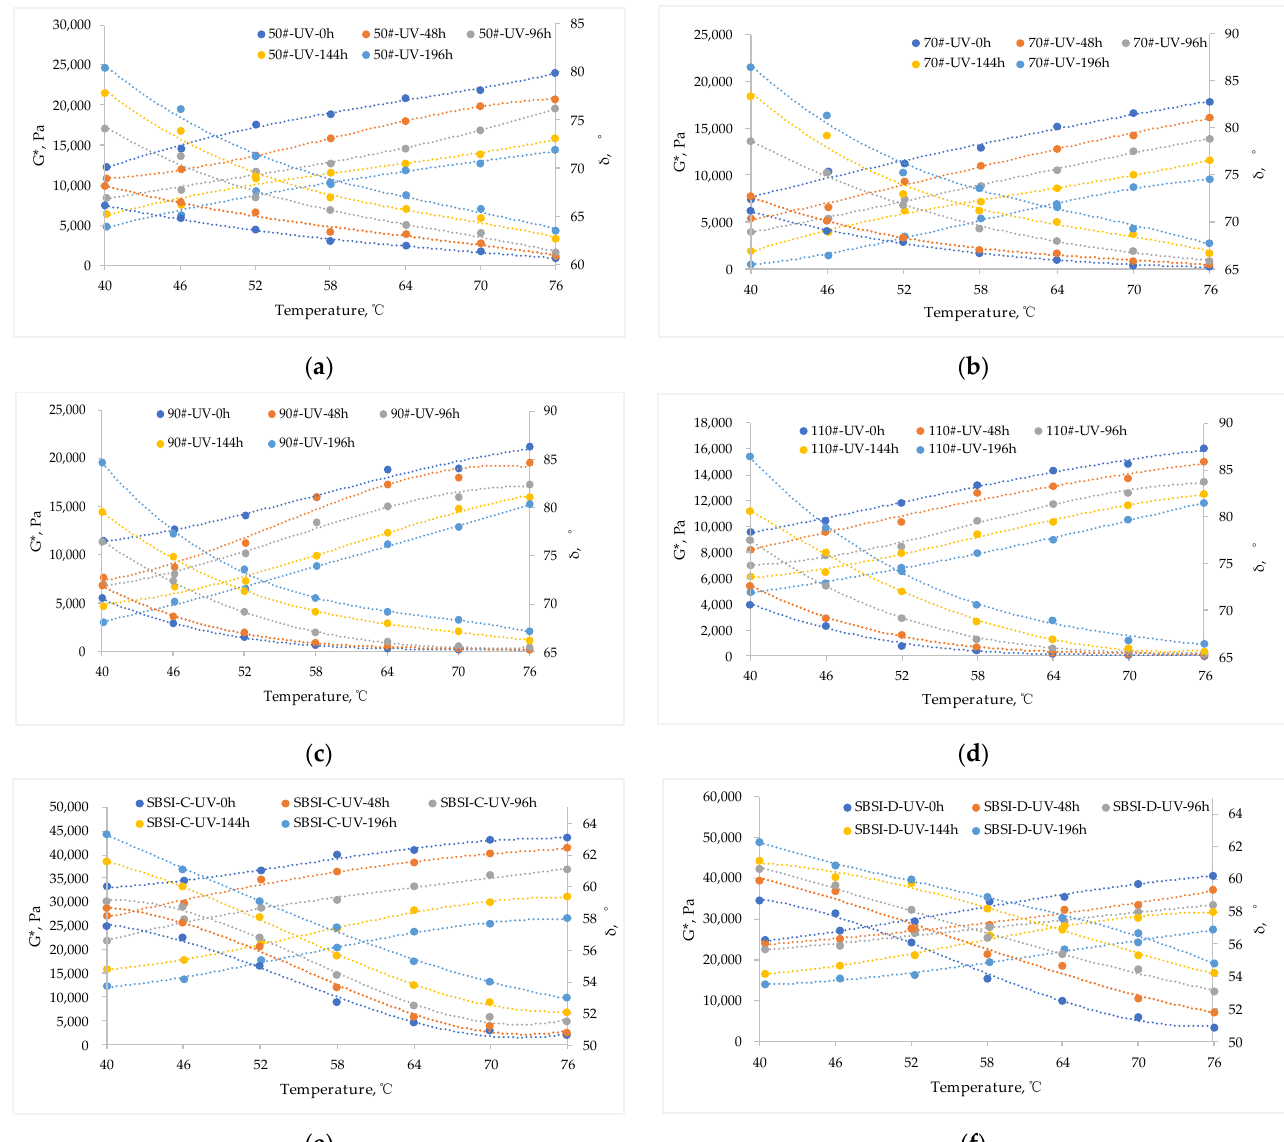
Figure 11. G* and δ of different asphalts under different UV irradiation times and temperatures: ( a ) 50 # ; ( b ) 70 # ; ( c ) 90 # ; ( d ) 110 # ; ( e ) SBS I-C; ( f ) SBS I-D.